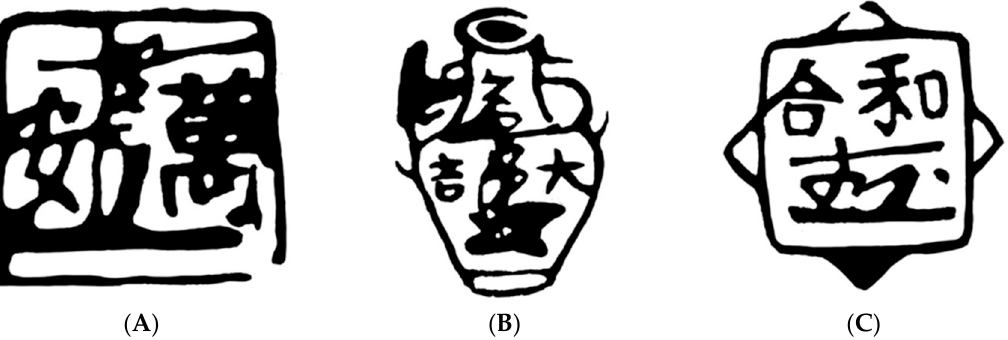
Figure 4. ( A ) A Song Yuan Huaya with Chinese characters “Wanan” and an ethnic element. The period of the Song and Yuan Dynasties. Sketched by author. Picture source: Shi (1995), p. 60. ( B ) A Song Yuan Huaya with Chinese characters “Daji 大吉 ” and an ethnic element. The period of the Song and Yuan dynasties. Inventory number: 1873. Sketched by author. Picture source: Wen (1995), p. 436. The original collection: Qingqing, Wu. Shiliu Jinfu Zhai Yin Cun [ 《十六金符齋印存》 ]. Book of impressions. The Fourteenth year of Guangxu, the Qing dynasty. ( C ) A Song Yuan Huaya with Chinese characters “Hehe 和合 ” and an ethnic element. The period of the Song and Yuan Dynasties. Inventory number: 1684. Sketched by author. Picture source: Wen (1995), p. 402.